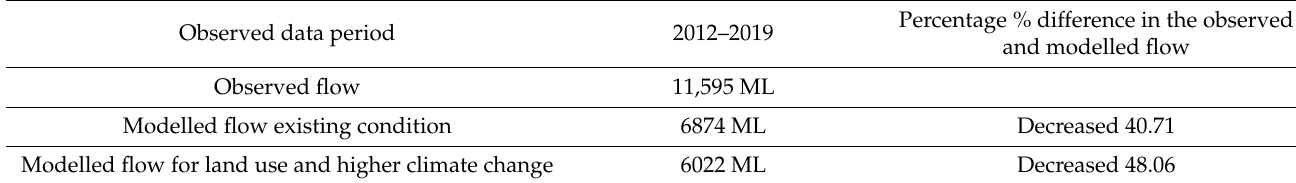
Table 13. Streamflow before and after the combined land-use and climate change